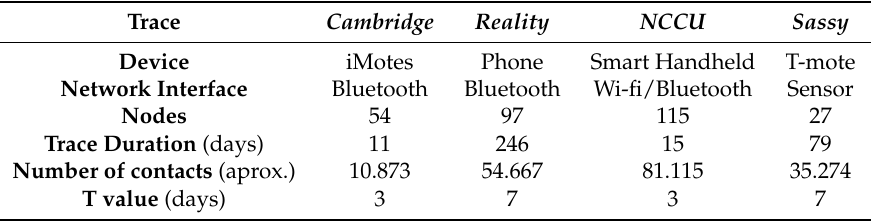
Table 1. Parameters describing the traces used in the